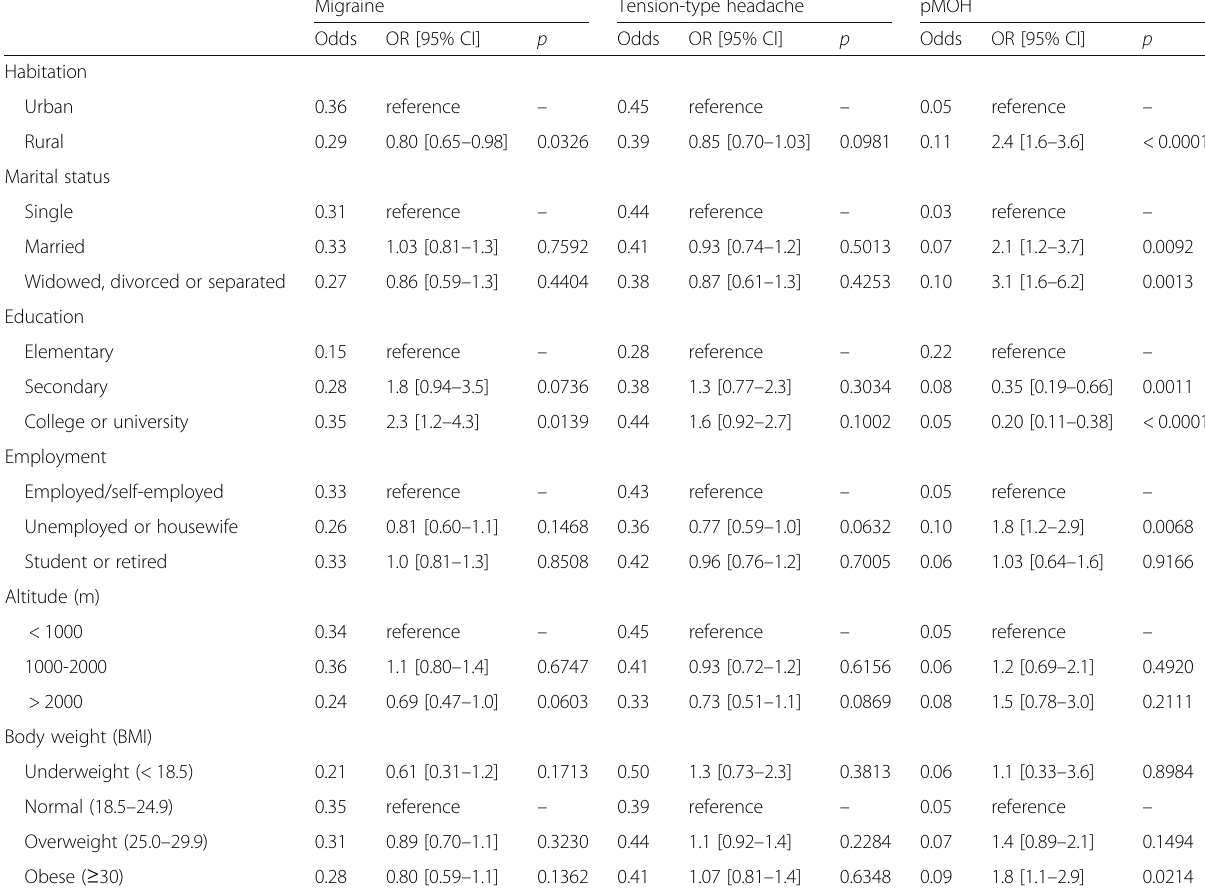
Table 3 Bivariate analysis of associations with the principal headache